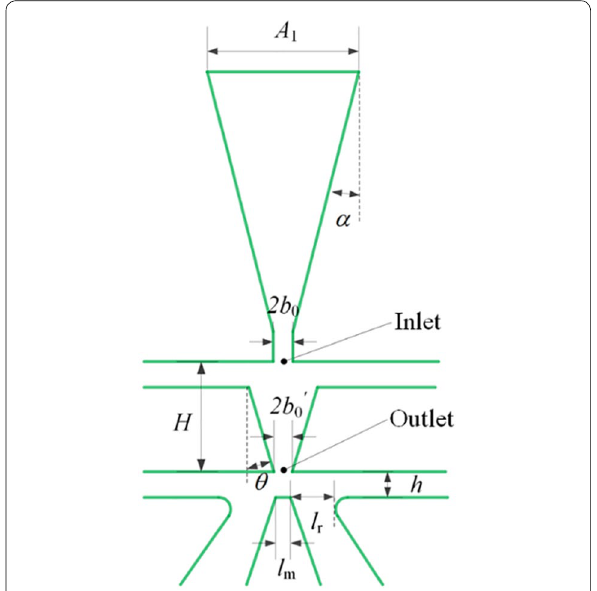
Figure 2 Definition of parameter